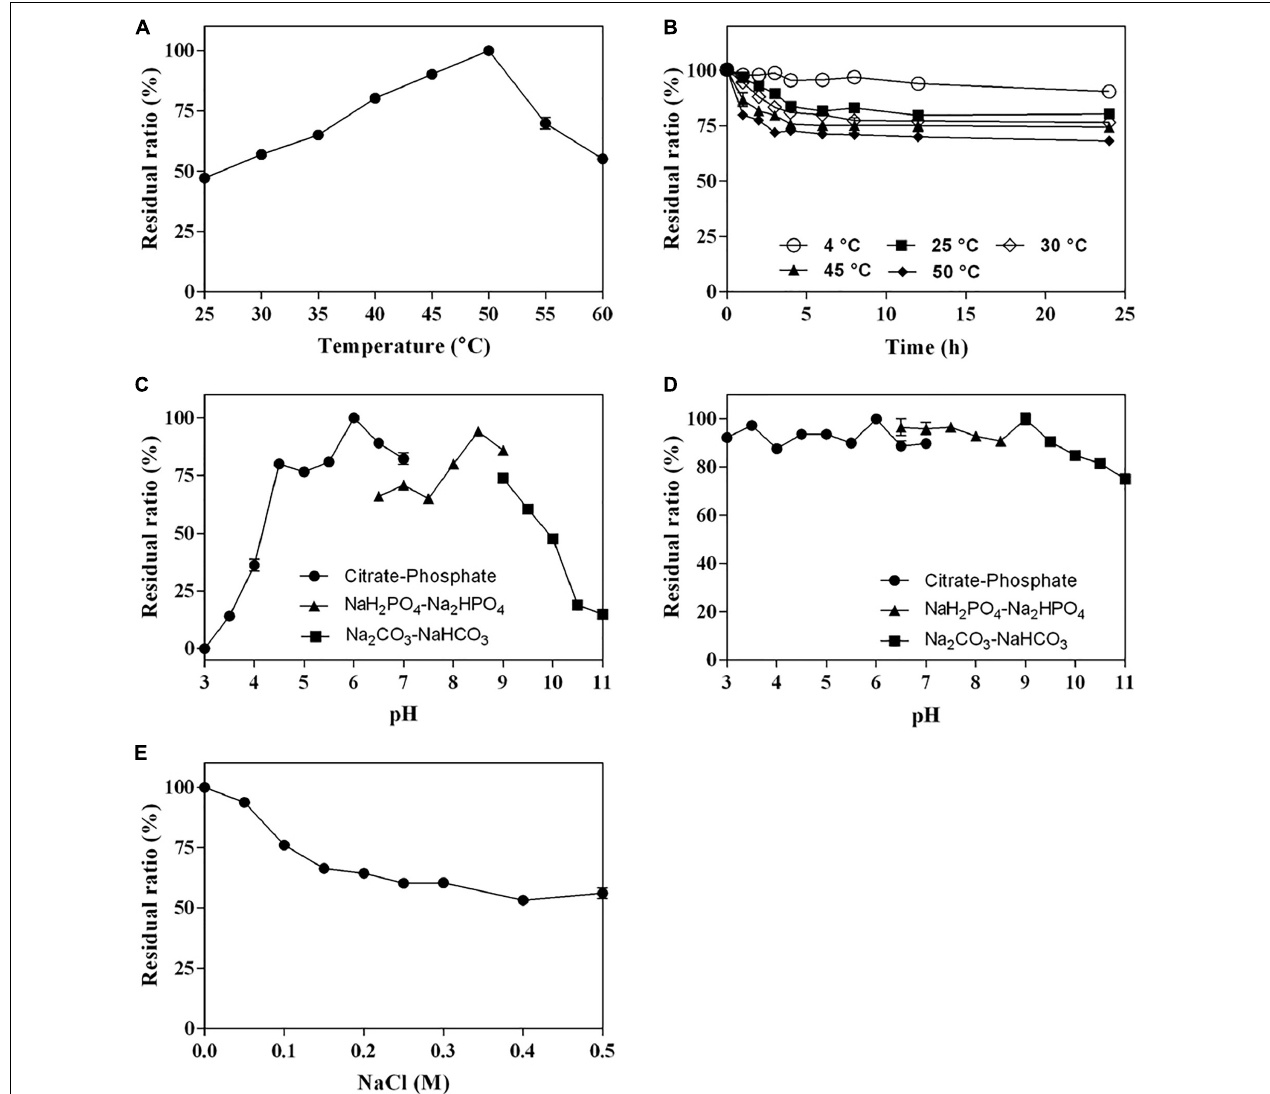
FIGURE 4 | Biochemical characteristics of Cgbk16A_Wf: (A) effect of temperatures on enzyme activity; (B) thermal stability; (C) effect of pH on enzyme activity; (D) pH stability; and (E) impact of NaCl concentration. TABLE 1 | Effect of metal ions and reagents (1 and 5 mmol/l) on the activity of Cgbk16A_Wf. Compound Relative activity (%)